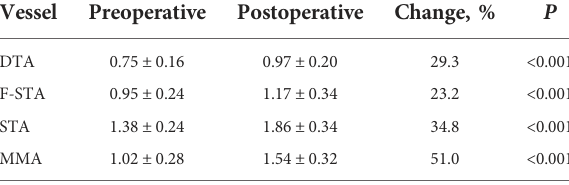
TABLE 3 Measurements of change in vessel size.